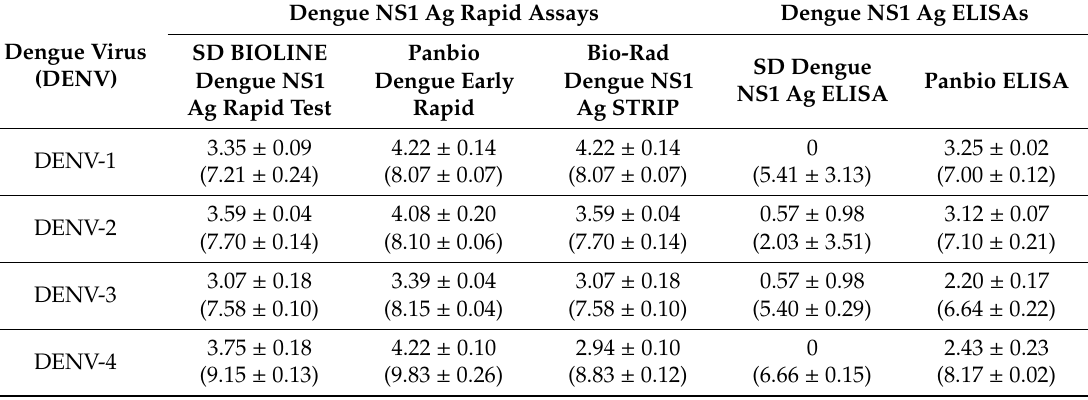
Table 2. Lowest titres of dengue virus serotypes detected by dengue nonstructural 1 antigen (NS1 Ag) detection